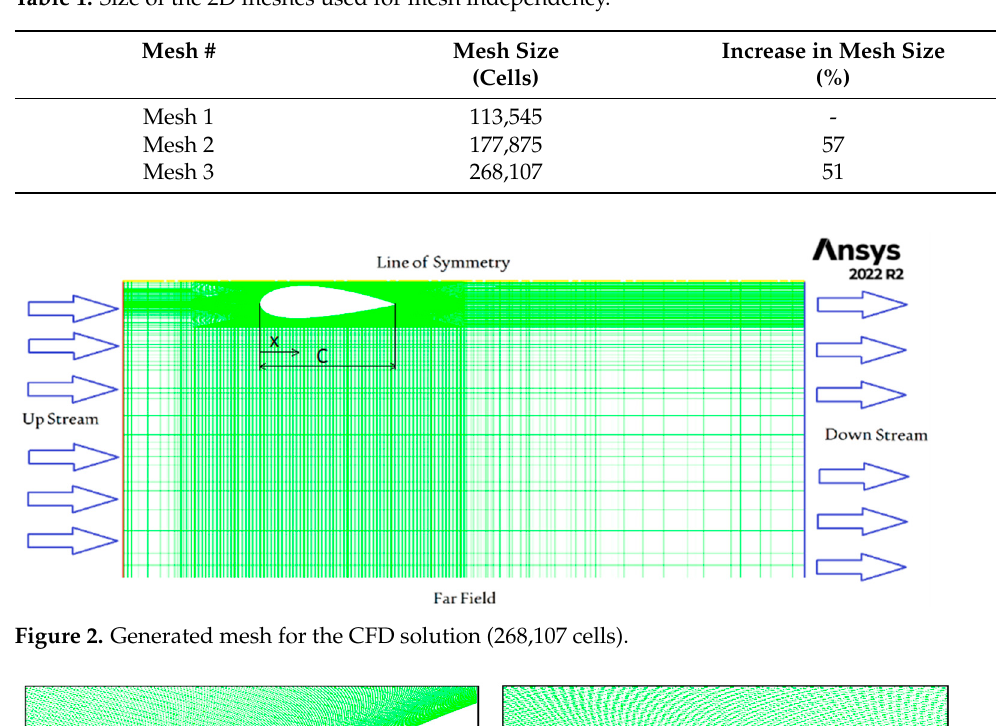
Table 1. Size of the 2D meshes used for mesh independency.